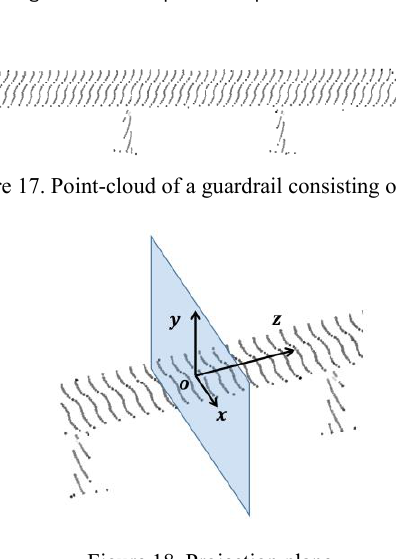
Figure 16. Skeletons of horizontal and curved